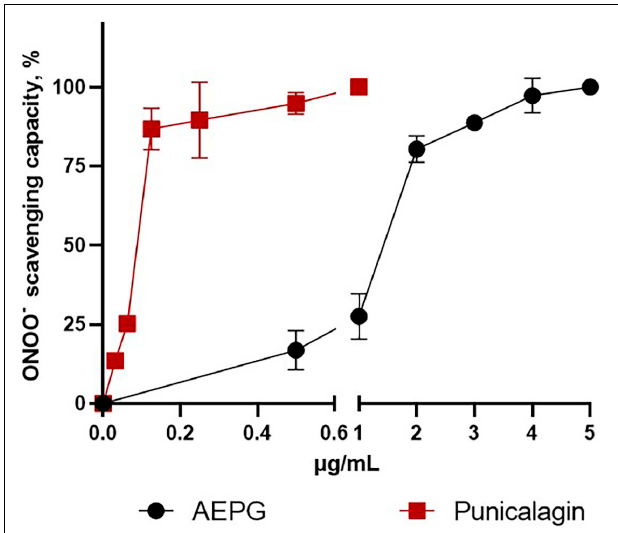
FIGURE 6 | Peroxynitrite (ONOO − )-scavenging capacity of AEPG, commercial punicalagin, and ellagic acid in a chemical combinatorial system. Ellagic acid had no effect. Data are represented as mean values ± S.E.M. of three to five experiments per